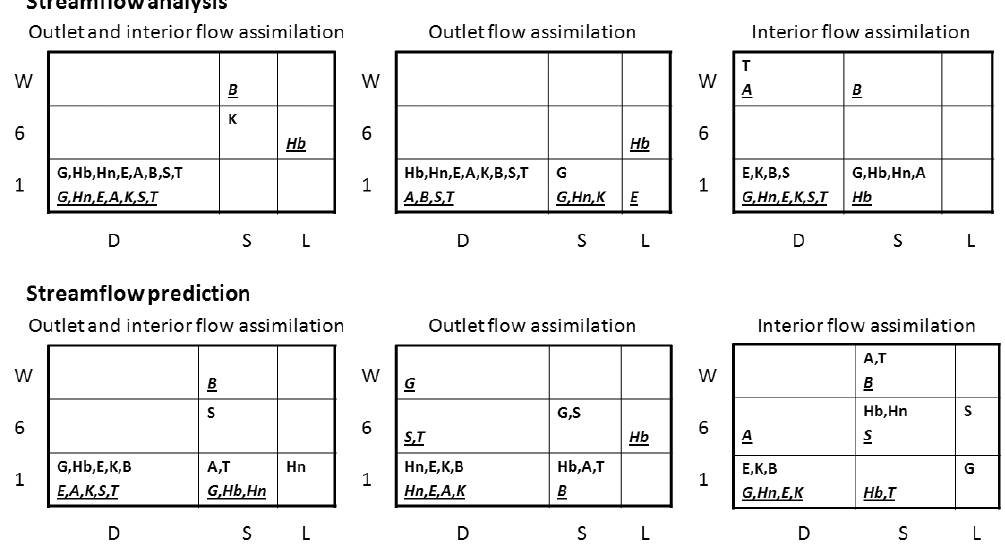
Fig. 9. Optimum spatiotemporal scales of adjustment for streamflow analysis and prediction for each basin and assimilation scenario. Underscored italic letters represent interior flow results and the others represent outlet flow results (A: ATIT2, B: BLUO2, E: ELDO2, G: GBHT2, Hb: HBMT2, Hn: HNTT2, K: KNLT2, S: SLOA4, T: TIFM7). 843